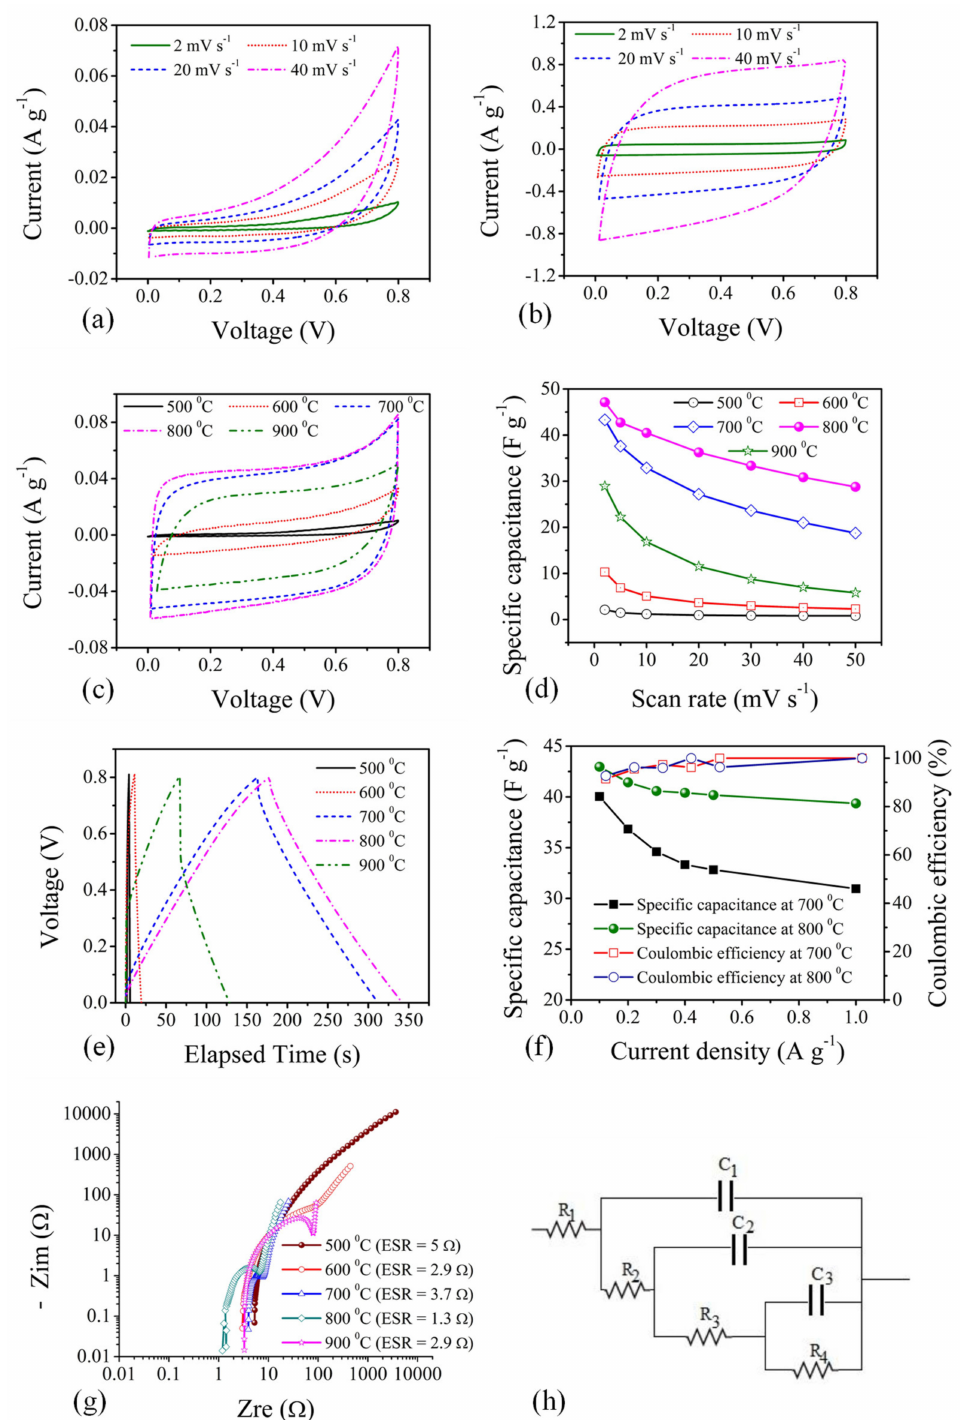
Figure 7. Electrochemical performance of CX electrodes at different temperatures: CV for CX- electrodes carbonised at ( a ) 500 ◦ C, and ( b ) 800 ◦ C, ( c ) CV comparison at 2 mV s − 1 , ( d ) rate capability with scan rate, ( e ) CP comparison at 0.1 A g − 1 , ( f ) rate capability and coulombic efficiency with current density, ( g ) Nyquist plot, and ( h ) equivalent circuit for fitting impedance